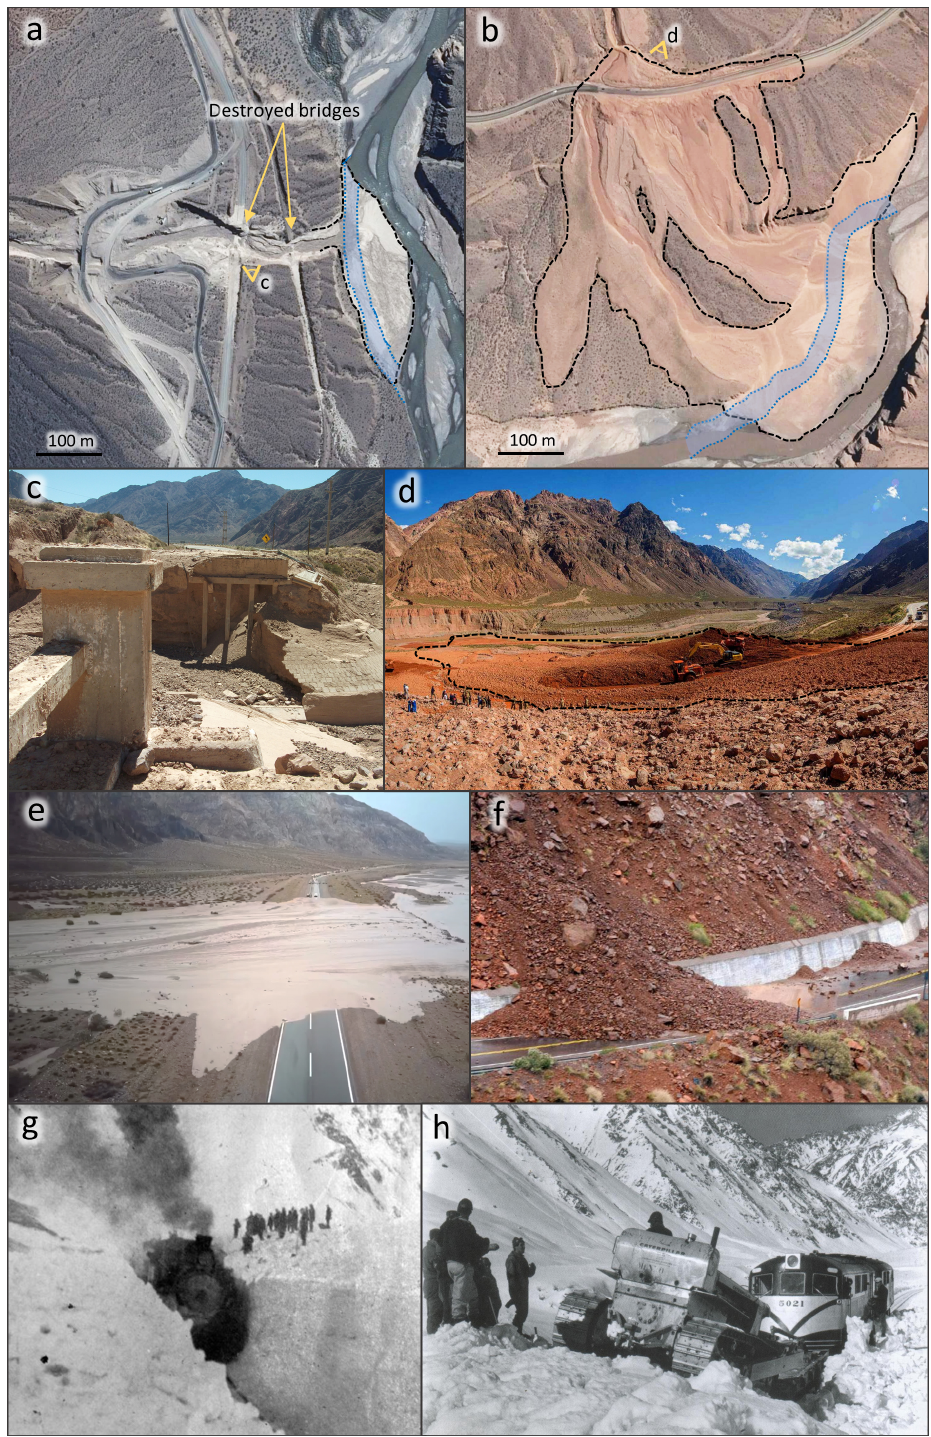
Figure 4. Pictures illustrating G-CHs in study area: (a, c) rainfall-driven debris flow occurred on 2 February 2016 in the E zone, (b, d) rainfall- driven debris flow occurred on 23 January 2016 in the E zone, (e) rainfall-driven debris flow occurred on 4 February 2018 in the E zone, (f) rainfall-driven debris falls occurred on 2 August 2013 in the E zone and (g, h) snow avalanches in the W